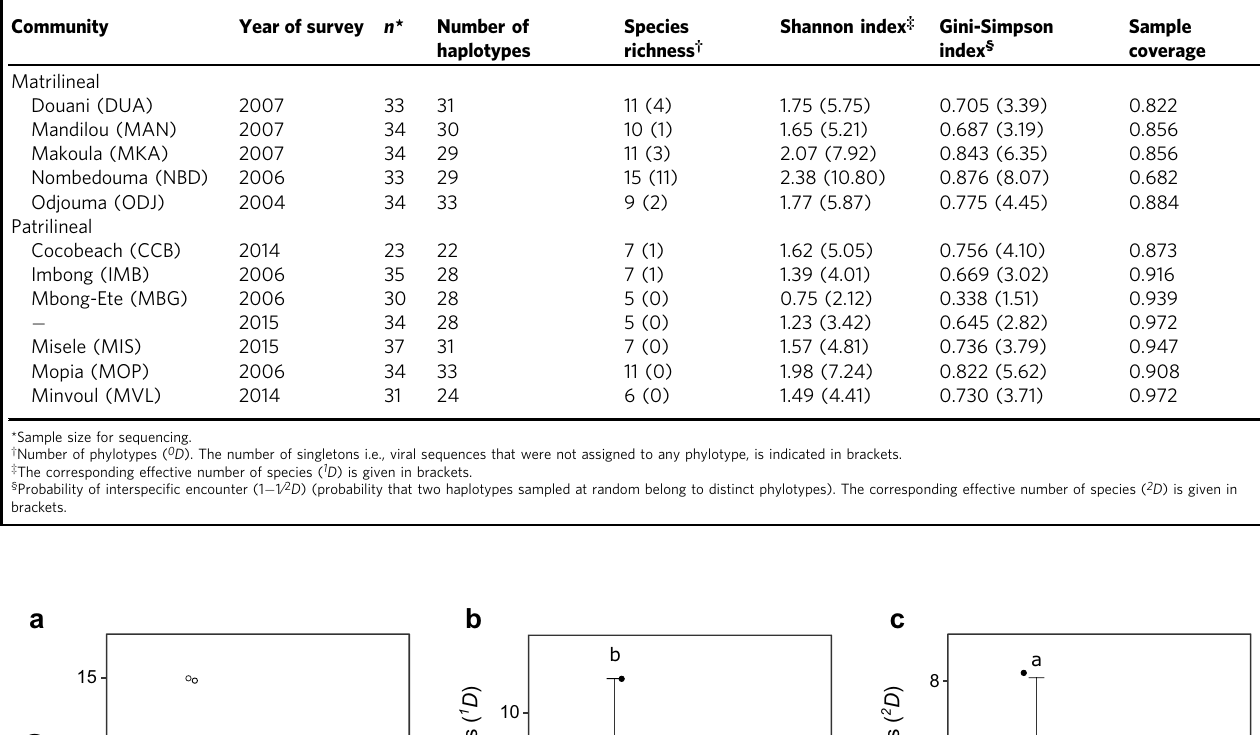
Table 3 ACMV phylogenetic diversity in the 11 communities surveyed. Community